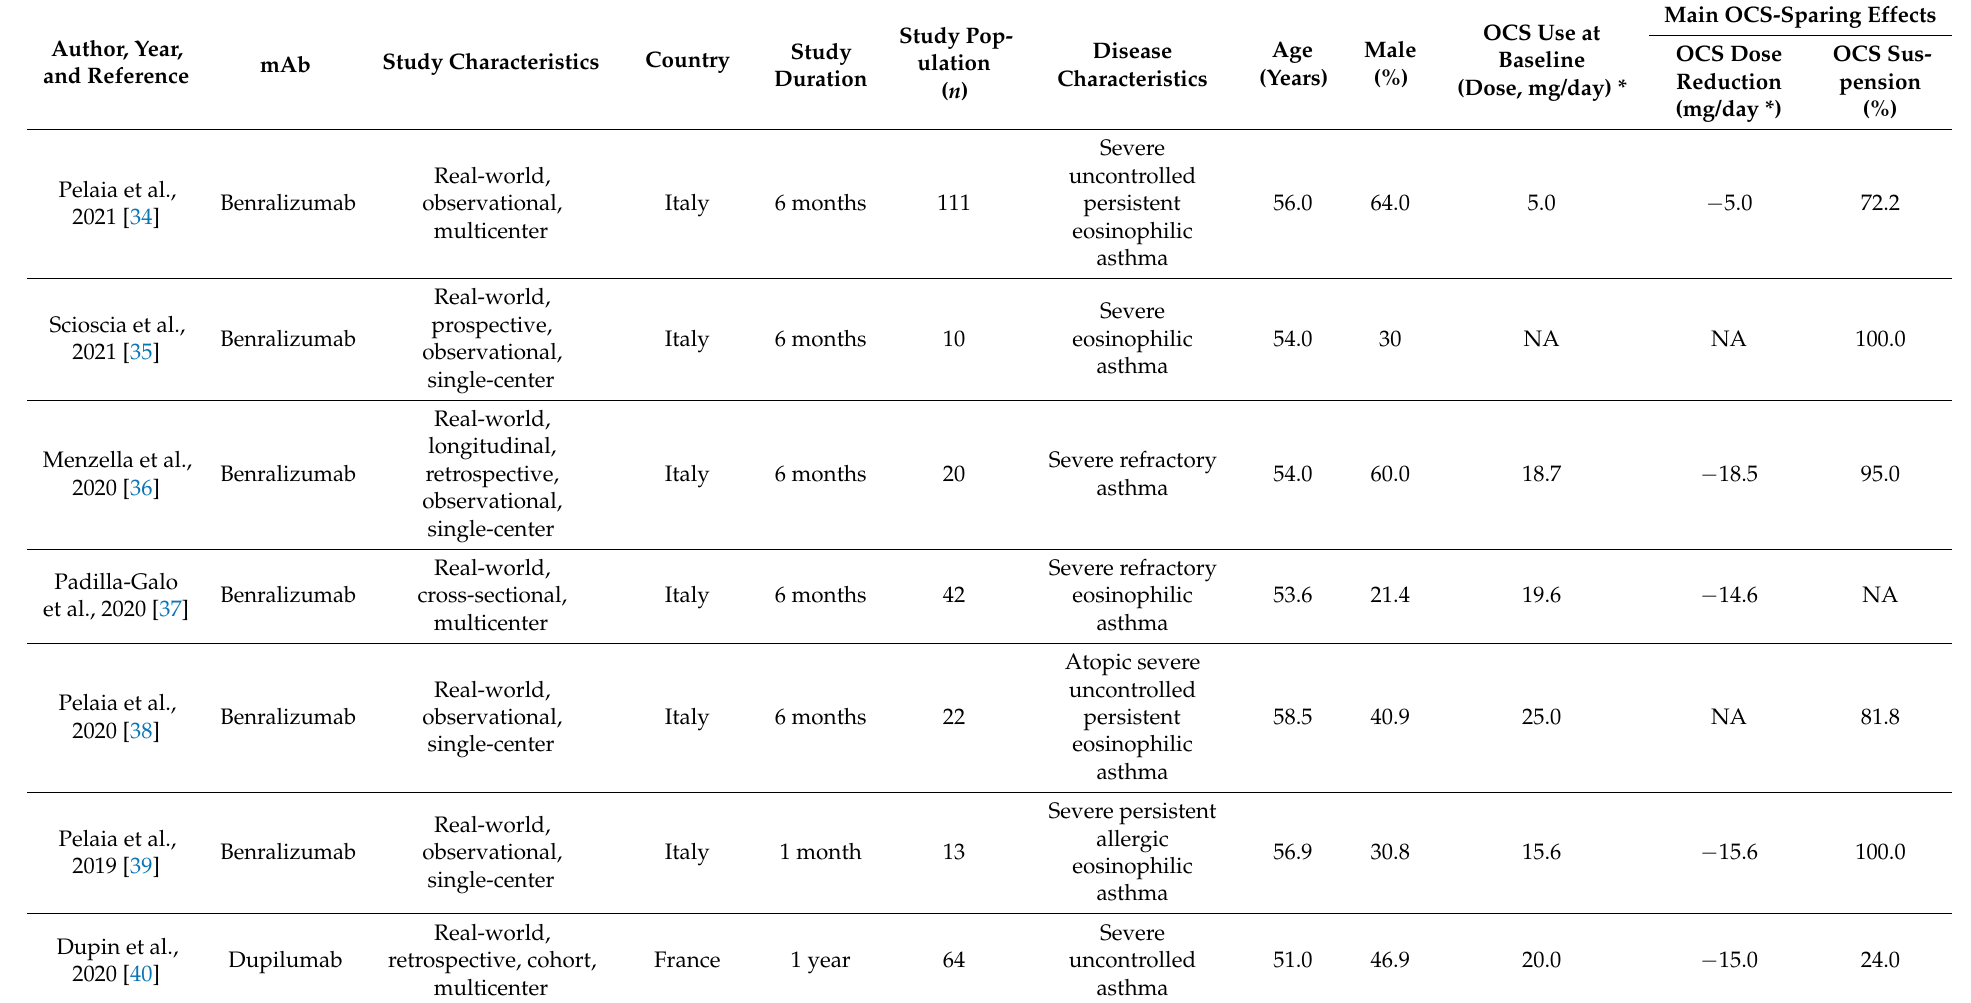
Table 1. Characteristics of the studies included in the systematic